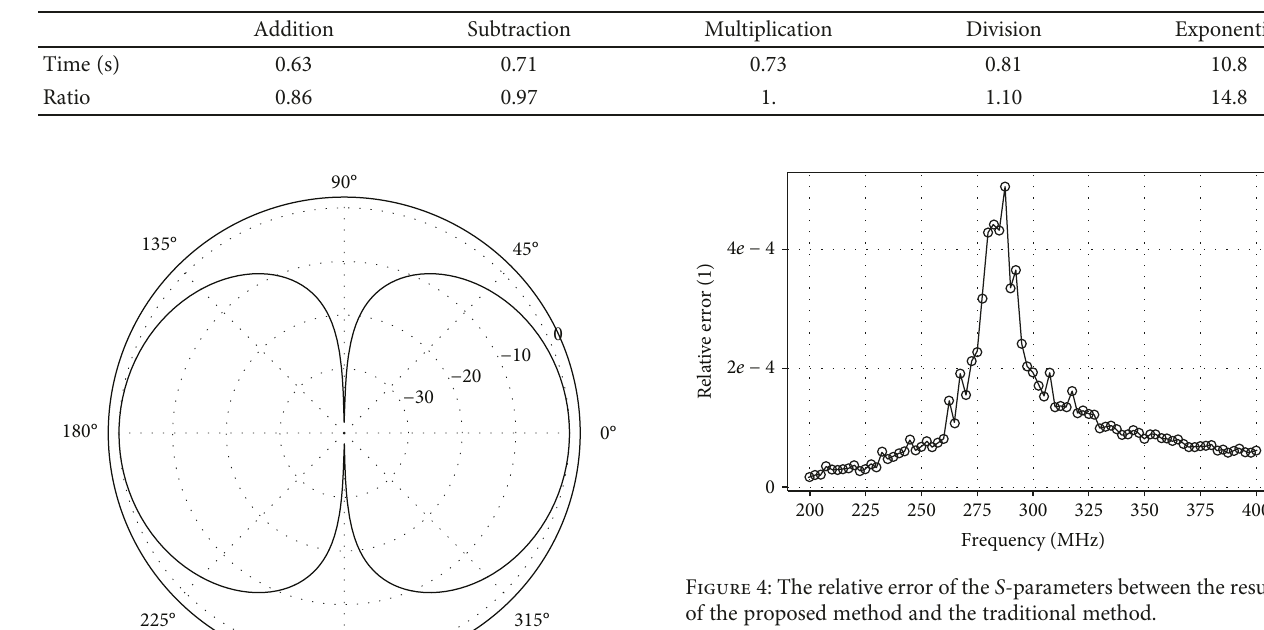
Table 2: The CPU time of di ff erent operations (repeated by 100 M times).